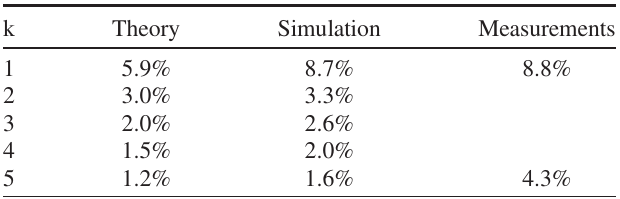
TABLE III. Comparison of the SPR spectral line widths: CST simulation, theoretical and measured